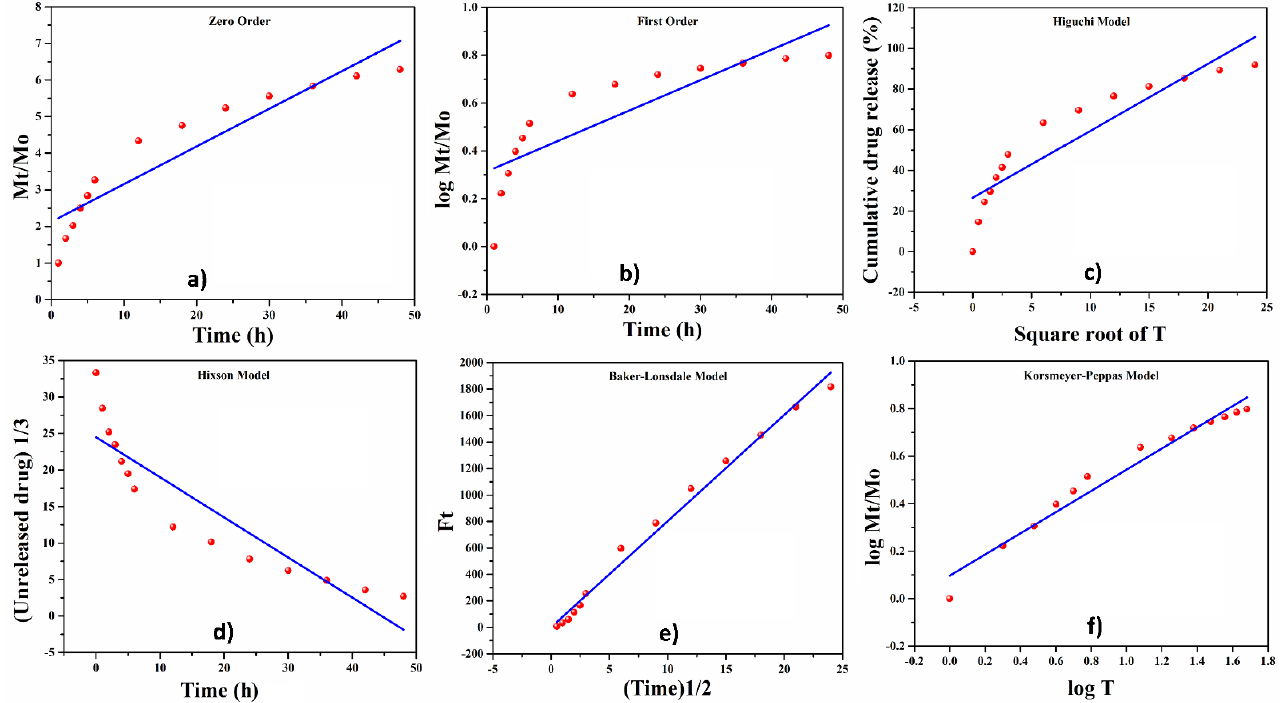
Figure 8. Kinetics models ( a ) zero-order, ( b ) first-order, ( c ) Higuchi, ( d ) Hixson–Crowell, ( e ) Baker–Lonsdale and ( f ) Korsmeyer–Peppas models) for drug release from hydrogels.